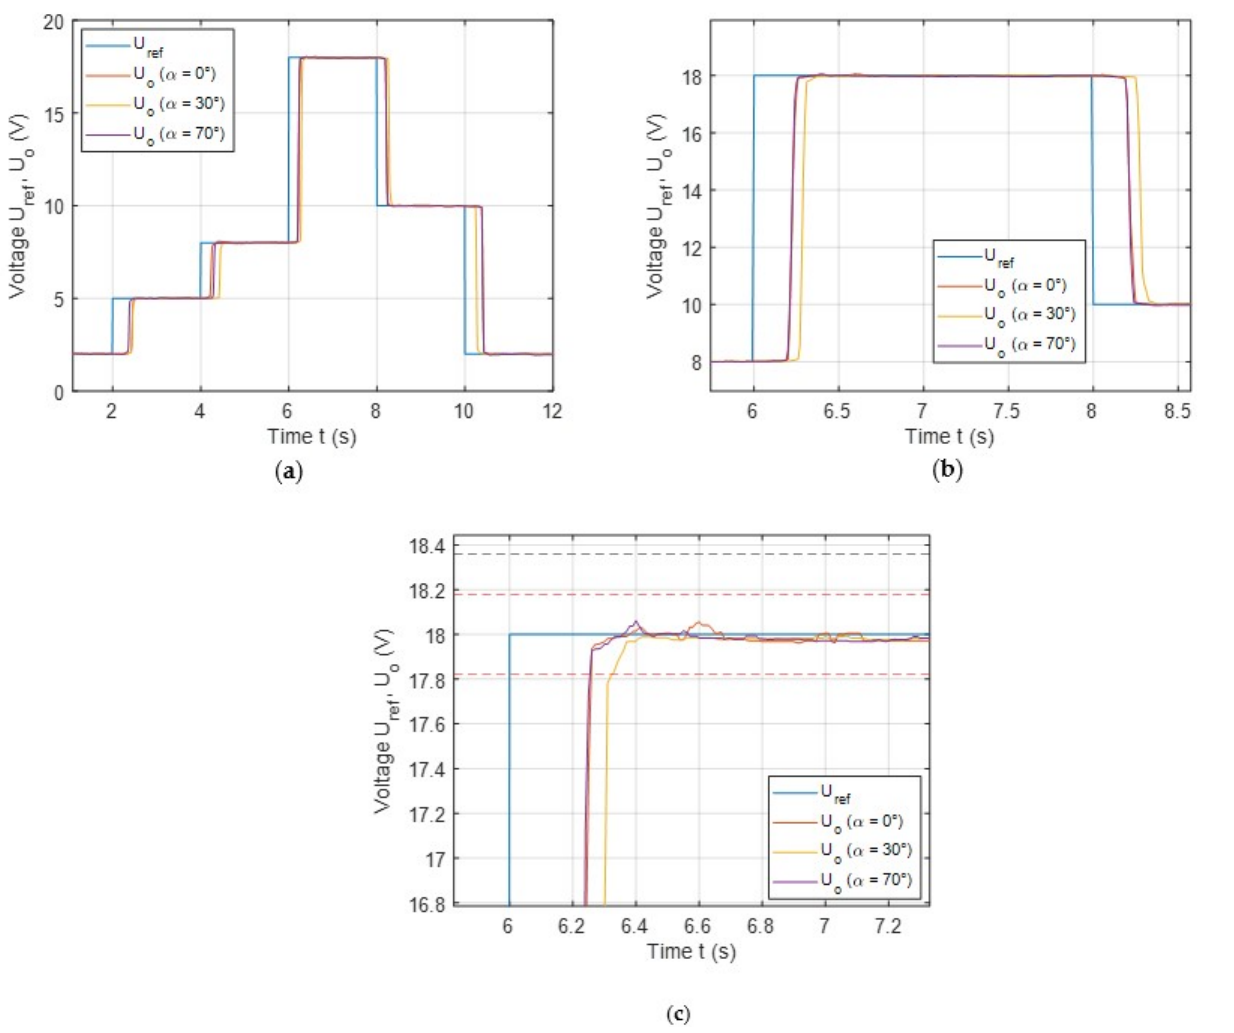
Figure 9. Step response of the IPT system using double DD coils at different angles α : ( a ) multiple steps; ( b ) one step response; ( c ) step response overshoot.